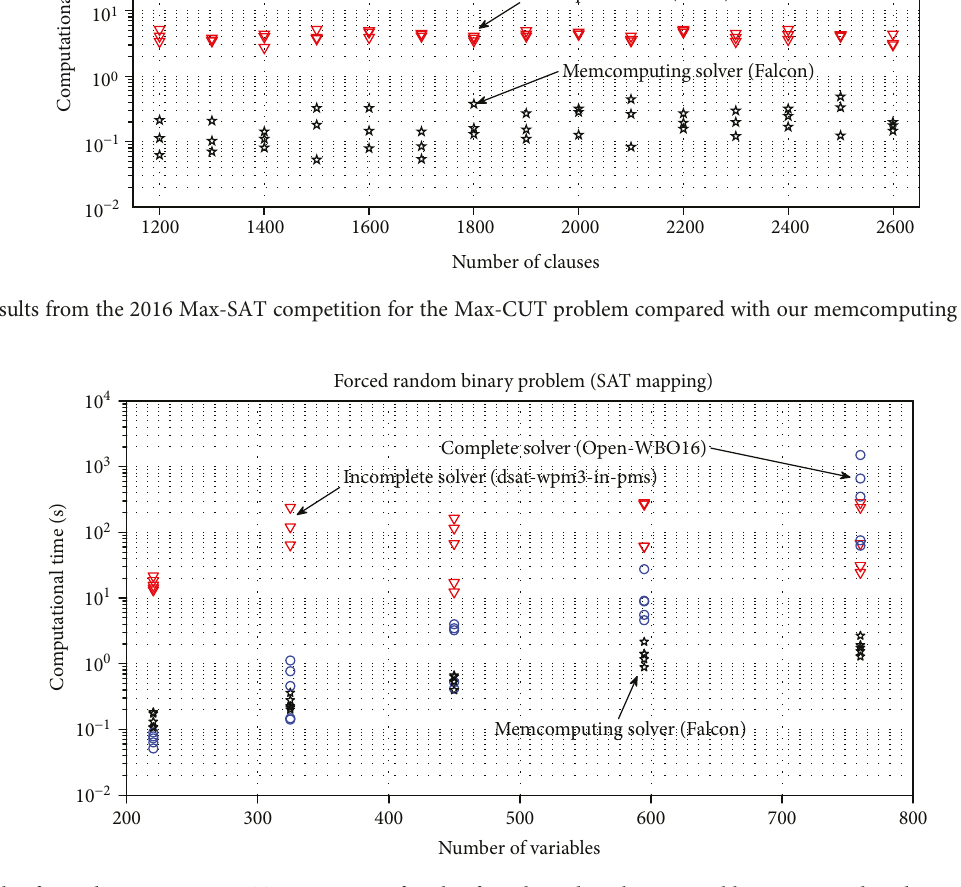
Figure 8: Results from the 2016 Max-SAT competition for the forced random binary problem compared with our memcomputing solver, Falcon.